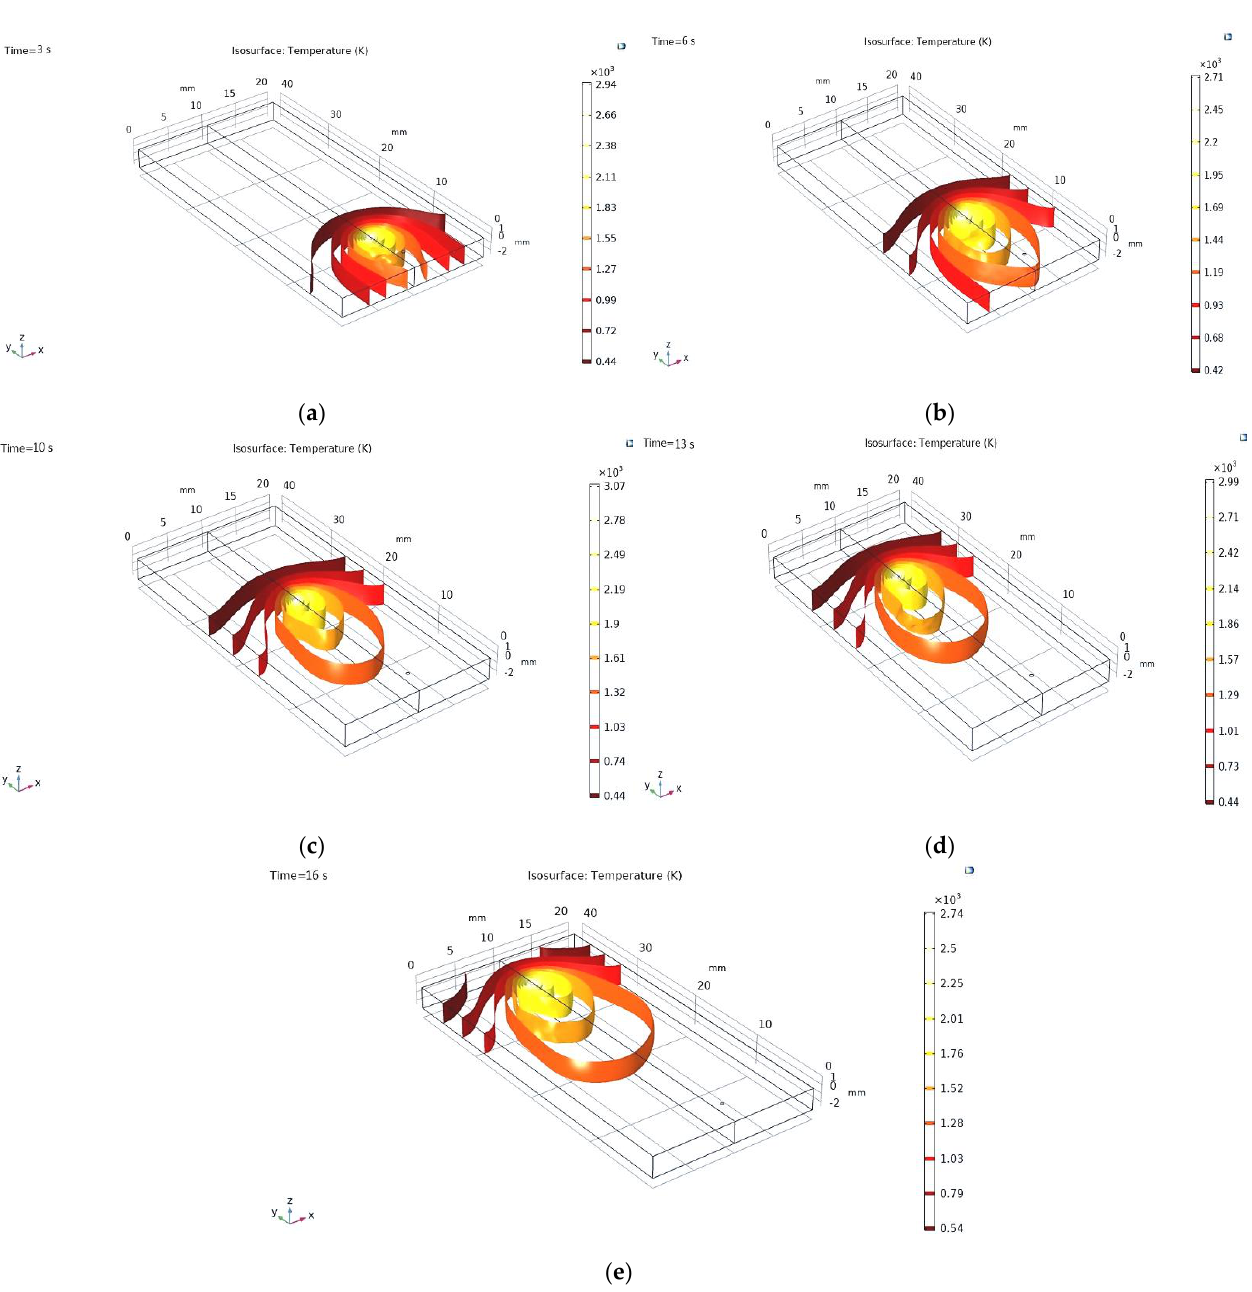
Figure 6. Isothermal contours at ( a ) t = 3 s, ( b ) t = 6 s, ( c ) t = 10 s, ( d ) t = 13 s, and ( e ) t = 16